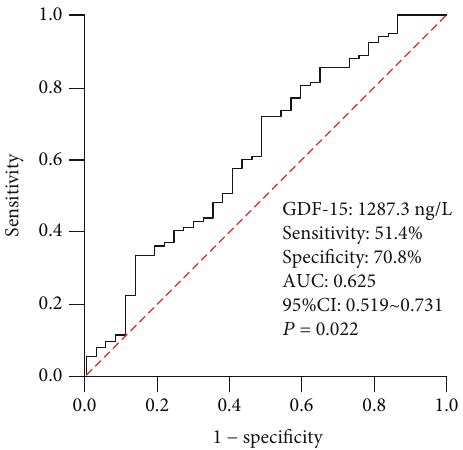
Figure 1: ROC curve analysis to determine the predictive value of GDF-15 for AF recurrence. AF: atrial fi brillation; AUC: area under the curve; CI: con fi dence interval; ROC: receiver operating characteristic; GDF-15: growth di ff erentiation